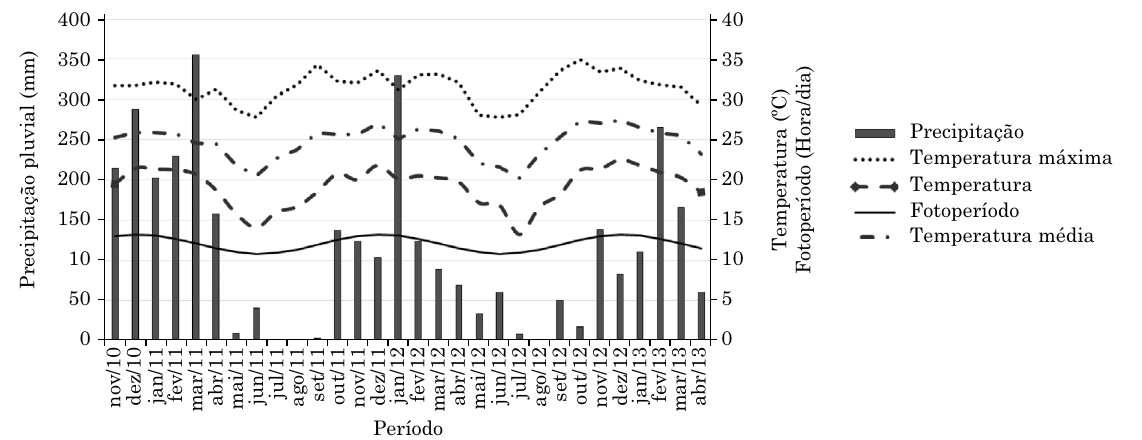
Figura 1. dados climáticos obtidos na estação meteorológica situada na Fazenda de ensino, Pesquisa e extensão da Fe/unesP, no município de selvíria, mato grosso do sul. Período de novembro/2010 a